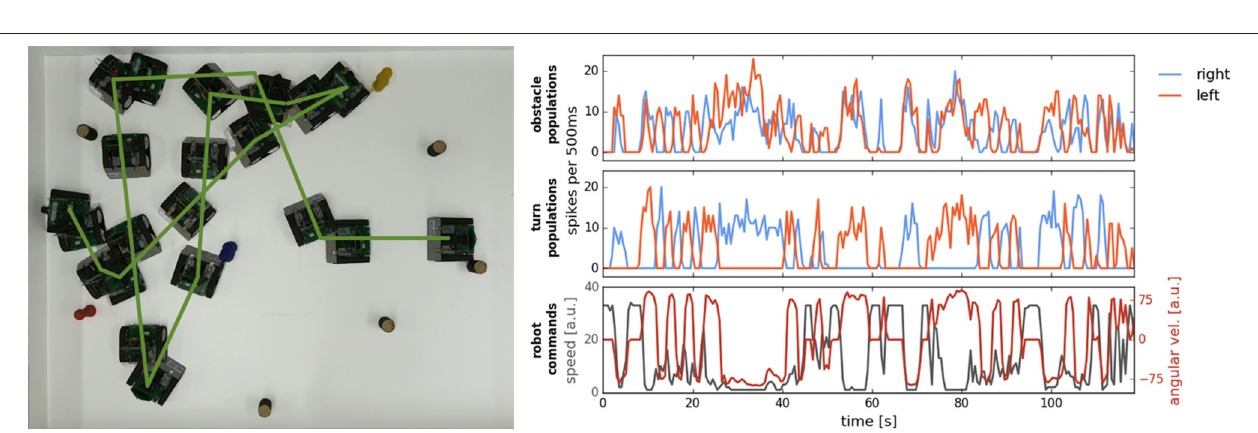
FIGURE 9 | Avoiding a moving obstacle. The same arrangement is used as in Figure 8 . See main text for the discussion.